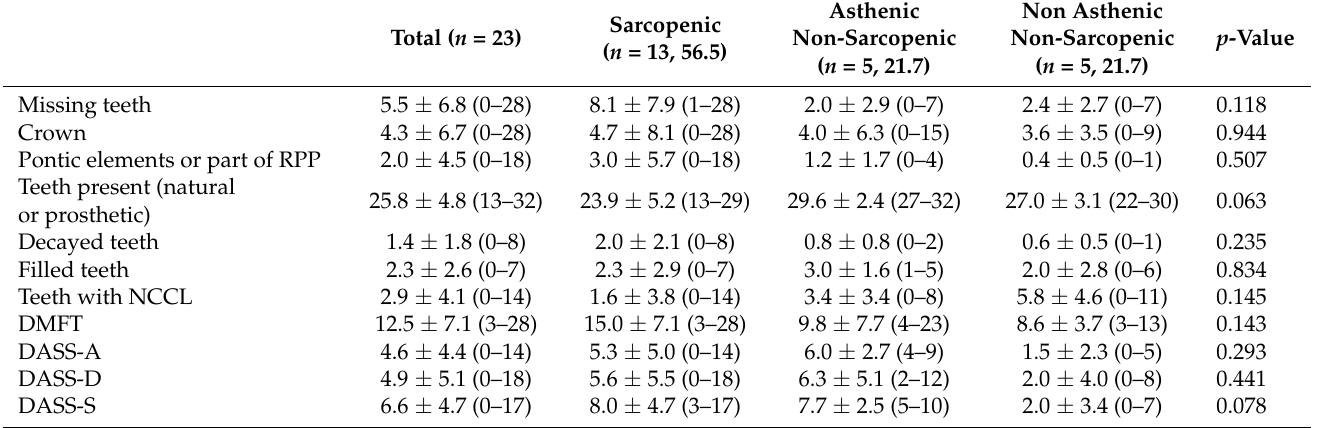
Table 1. Intra-oral dental visit and DASS questionnaire results: medium values of missing teeth, crowns, pontic elements or part of Removable Partial Prosthesis (RPP), caries, filled teeth, teeth with Non-Carious Cervical Lesion (NCCL) and Decay Missing Filled Teeth (DMFT); DASS-A; DASS-D; DASS-S.